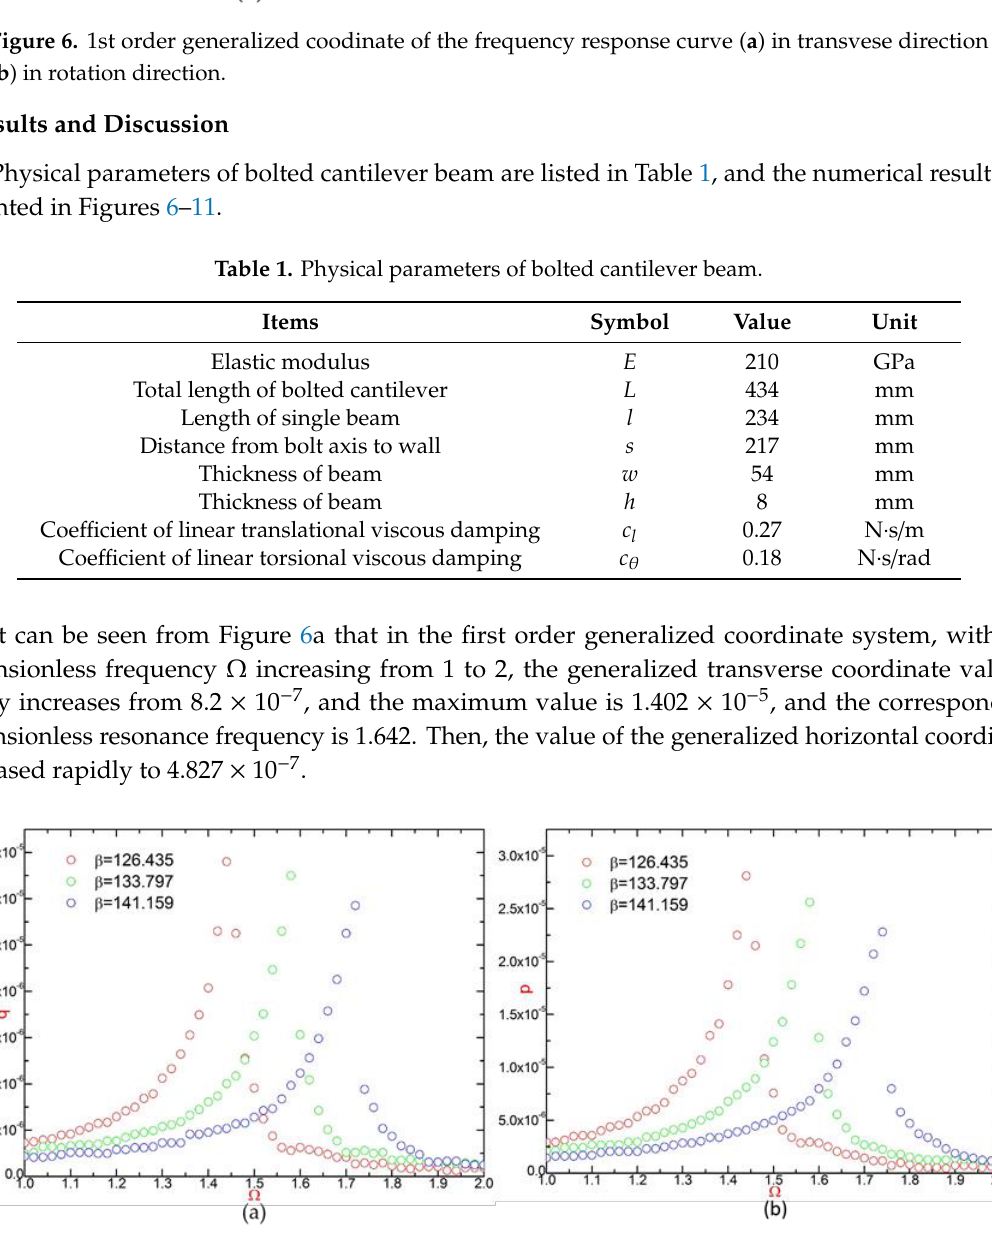
Figure 7. Influence of β in 1st order generalized coodinate of the frequency response curve ( a ) in transvese direction ( b ) in rotation direction.